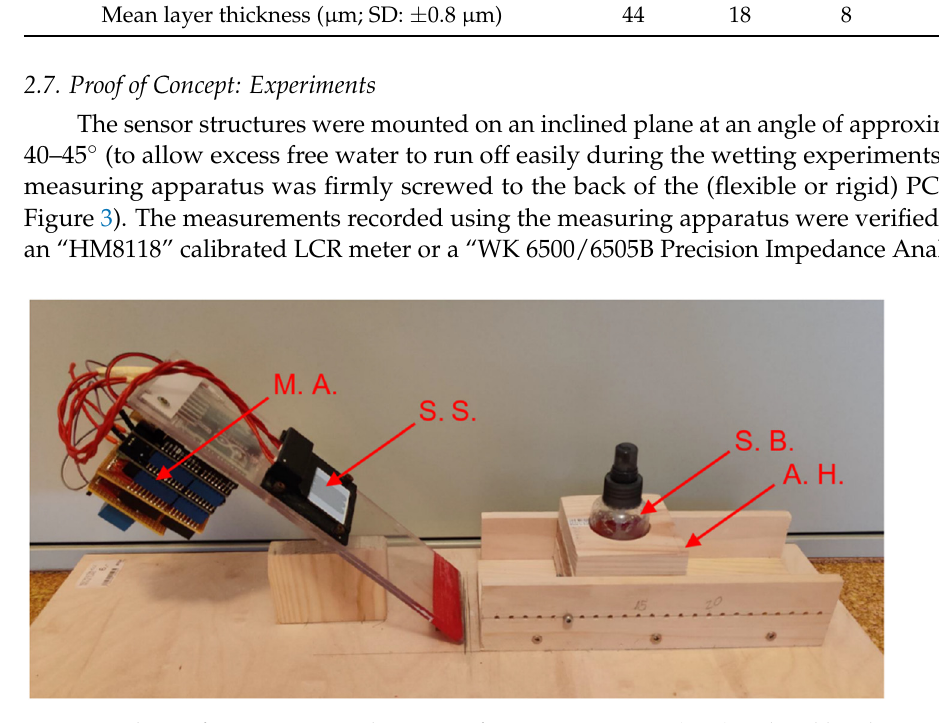
Figure 3. Photo of an experimental setup. Left: Sensor structure (S. S.) inclined by about 45 ◦ with measuring apparatus (M. A.) mounted on the back. Right: Adjustable holder (A. H.) for spray bottles (S. B.) used to spray water or hydrogel onto the sensor